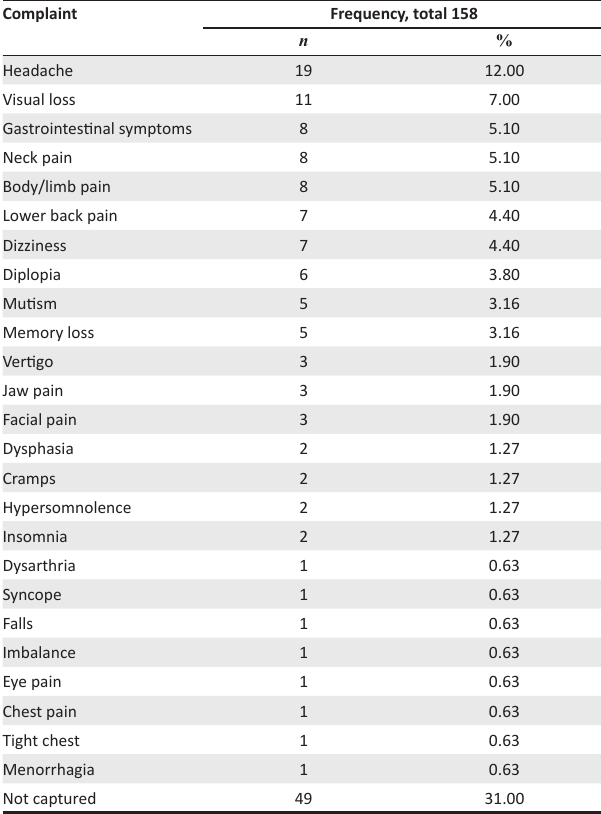
TABLE 3: Other presenting